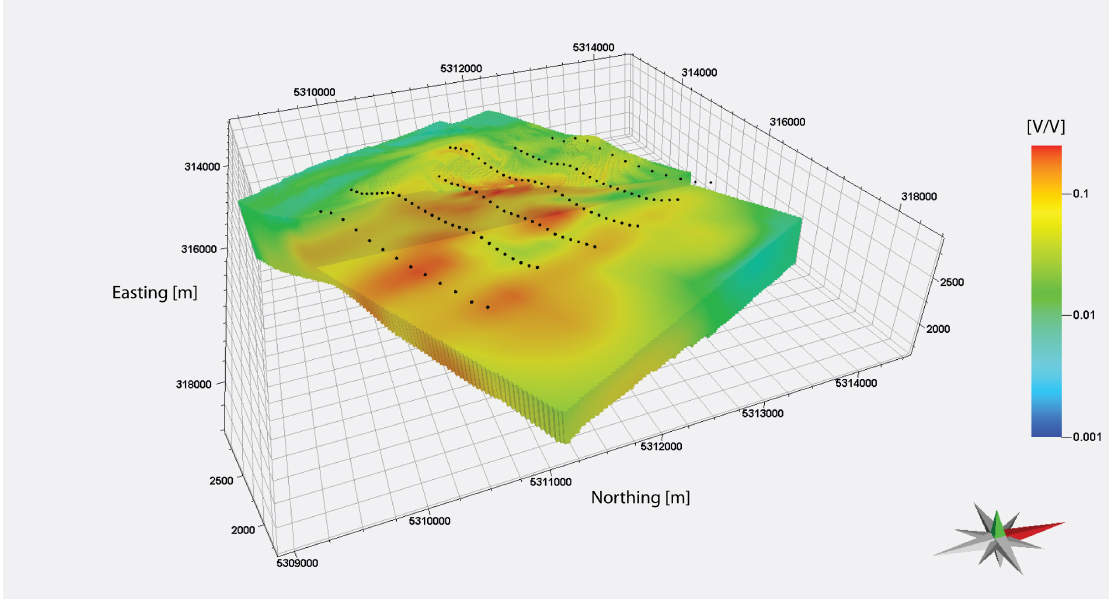
Figure 9. A 3D view of the 3D chargeability model recovered from 3D inversion of pole–dipole IP